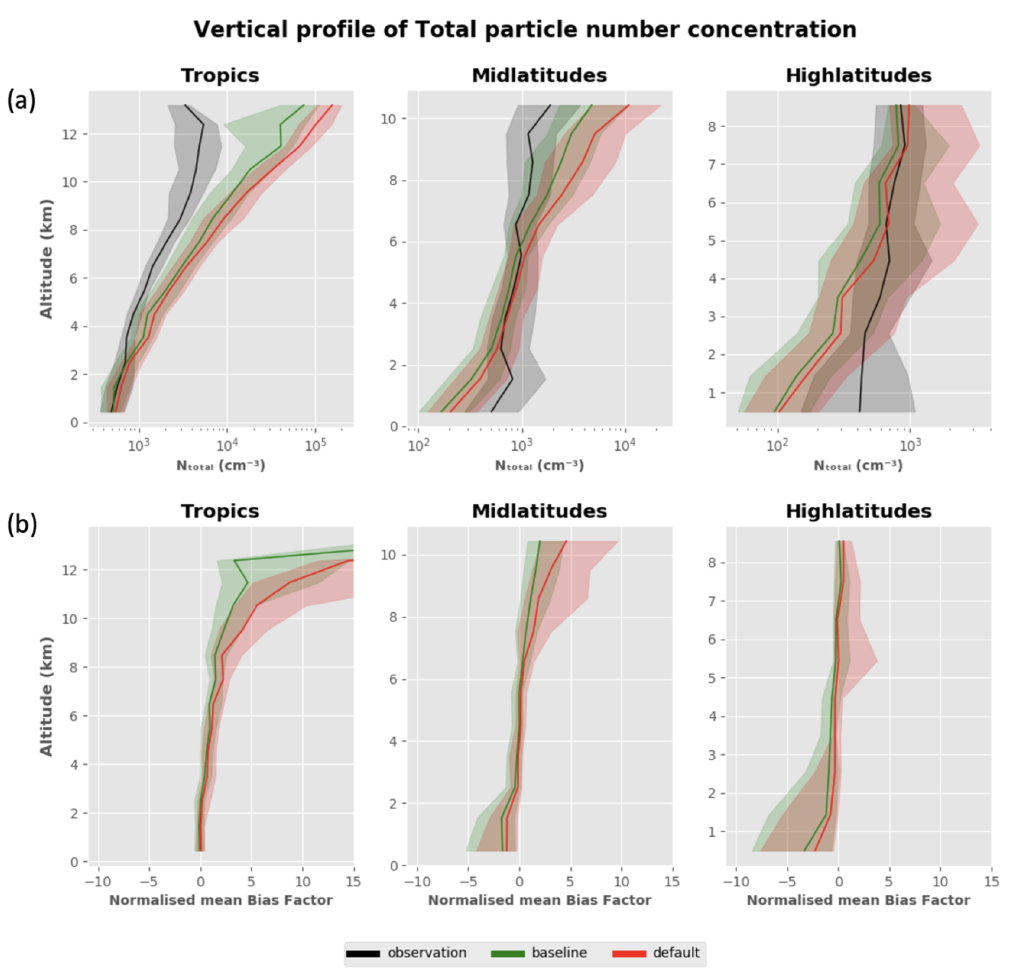
Figure A1. (a) The vertical profile of the total particle number concentration (at standard temperature and pressure – STP) as observed (ATom1–4) and in the simulated data from the default and baseline (bug-fixed) configurations of UKESM. (b) The vertical profile of the normalised mean bias factor (NMBF) for the two configurations of the model. The vertical profiles have been provided for the tropics (25 ◦ N– 25 ◦ S), mid latitudes (25–60 ◦ N and 25–60 ◦ S) and high latitudes (60–90 ◦ N and 60–90 ◦ S). In both (a) and (b) the bold line represents the median and the shaded region represents the corresponding interquartile range (25th and 75th percentiles) in a 1km altitude bin.